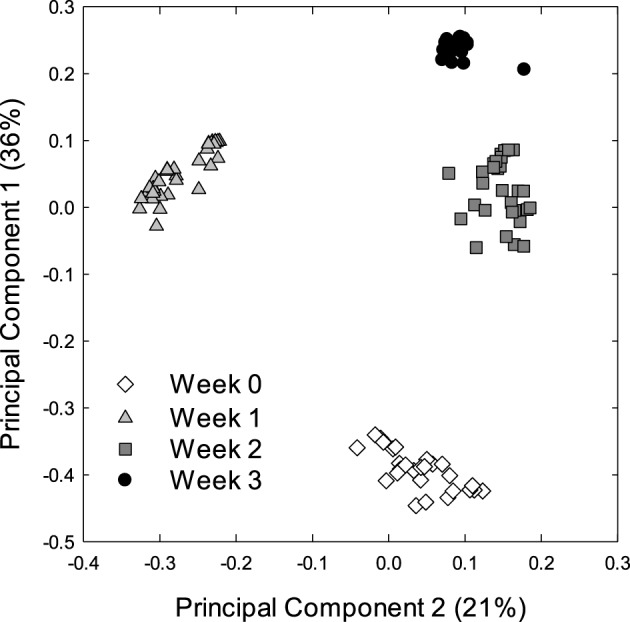
Principle coordinate analysis (PCA) of the bacterial microbiota of piglets. The PCA plot was generated using the unweighted UniFrac distance metric. Each dot represents an individual sample collected at the start of weaning week 0 (n = 29) or after week 1 (n = 36), week 2 (n = 36), and week 3 (n = 36) of weaning.